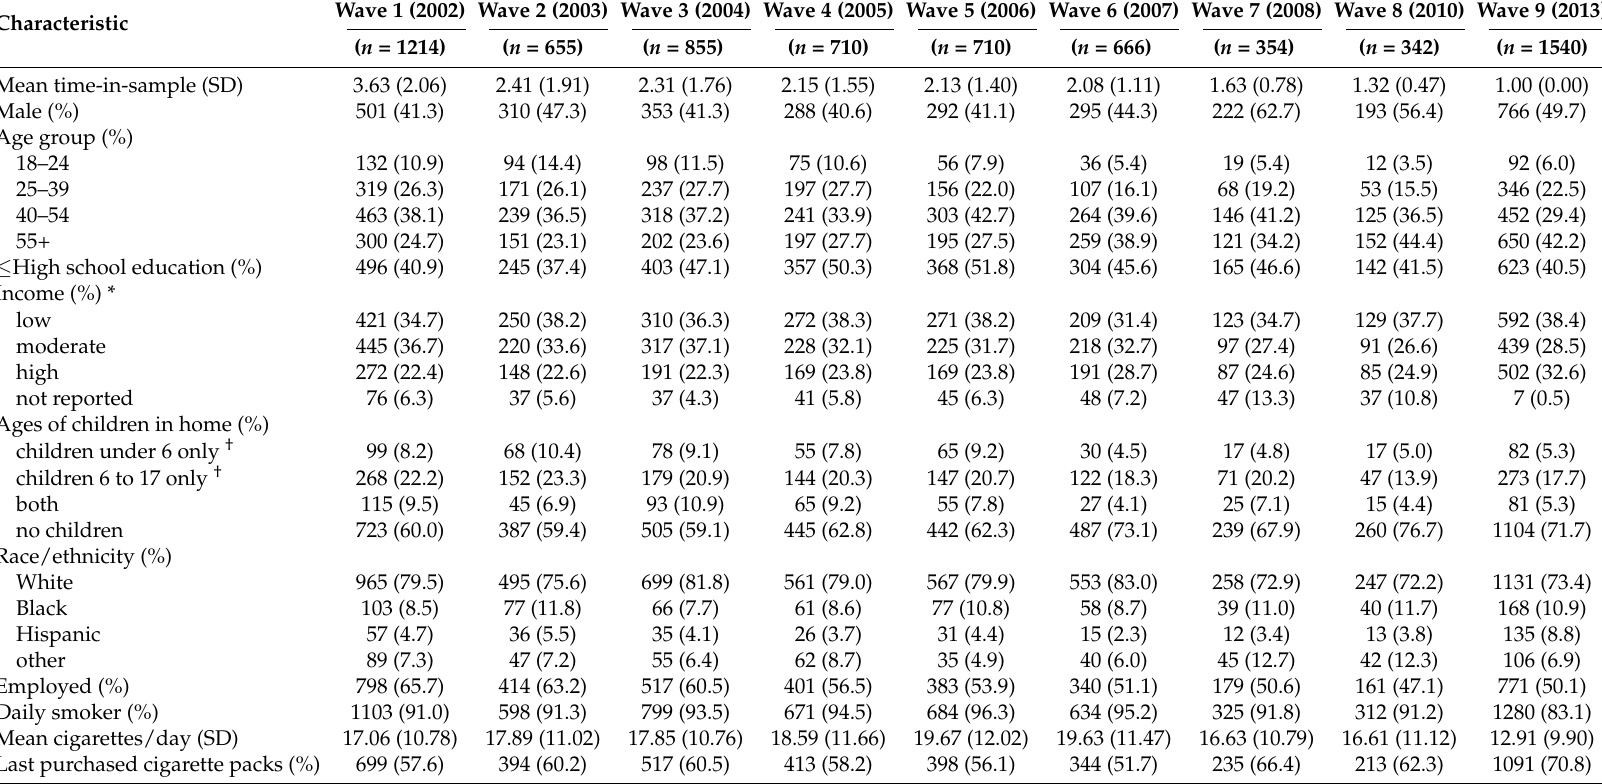
Table 2. Characteristics of smokers by wave of recruitment into the ITC US